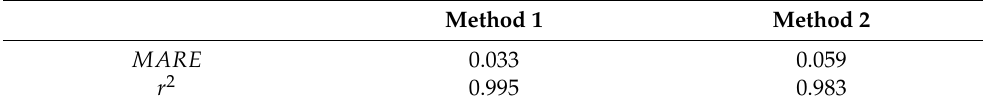
Table 3. The performance of the revisited model by methods 1 and 2, assessed by MARE (Equation (4a)) and r 2 (Equation (4b)).